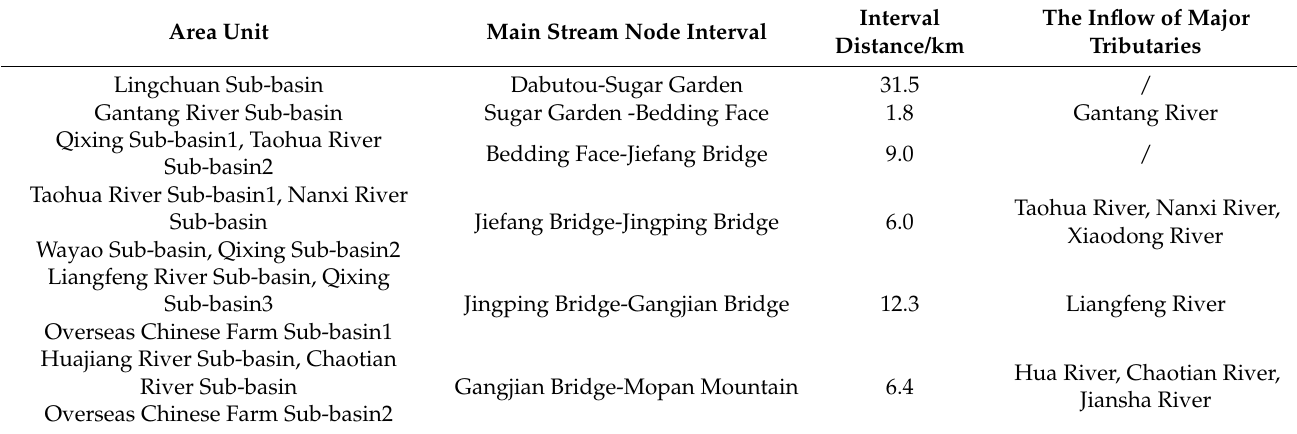
Table 1. Calculation unit, main stream, and